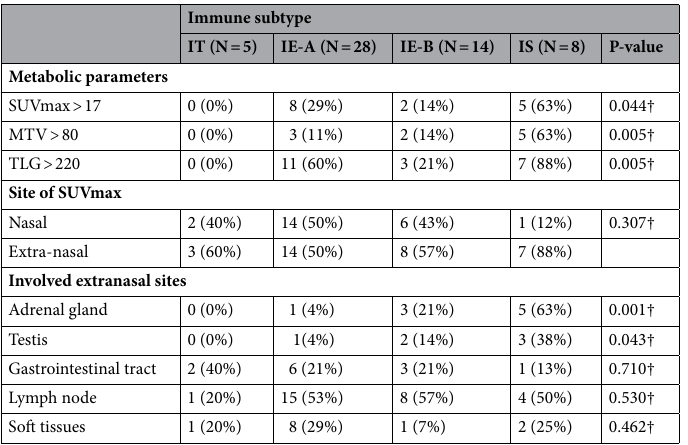
Table 3. Comparison of metabolic parameters according to immune subtype in the extra-nasal lesion subgroup. IT, immune tolerance; IE, immune evasion; IS, immune silenced; SUV, maximum standardized uptake value; MTV, metabolic tumor volume; TLG, total lesion glycolysis; †, Chi-squared test.